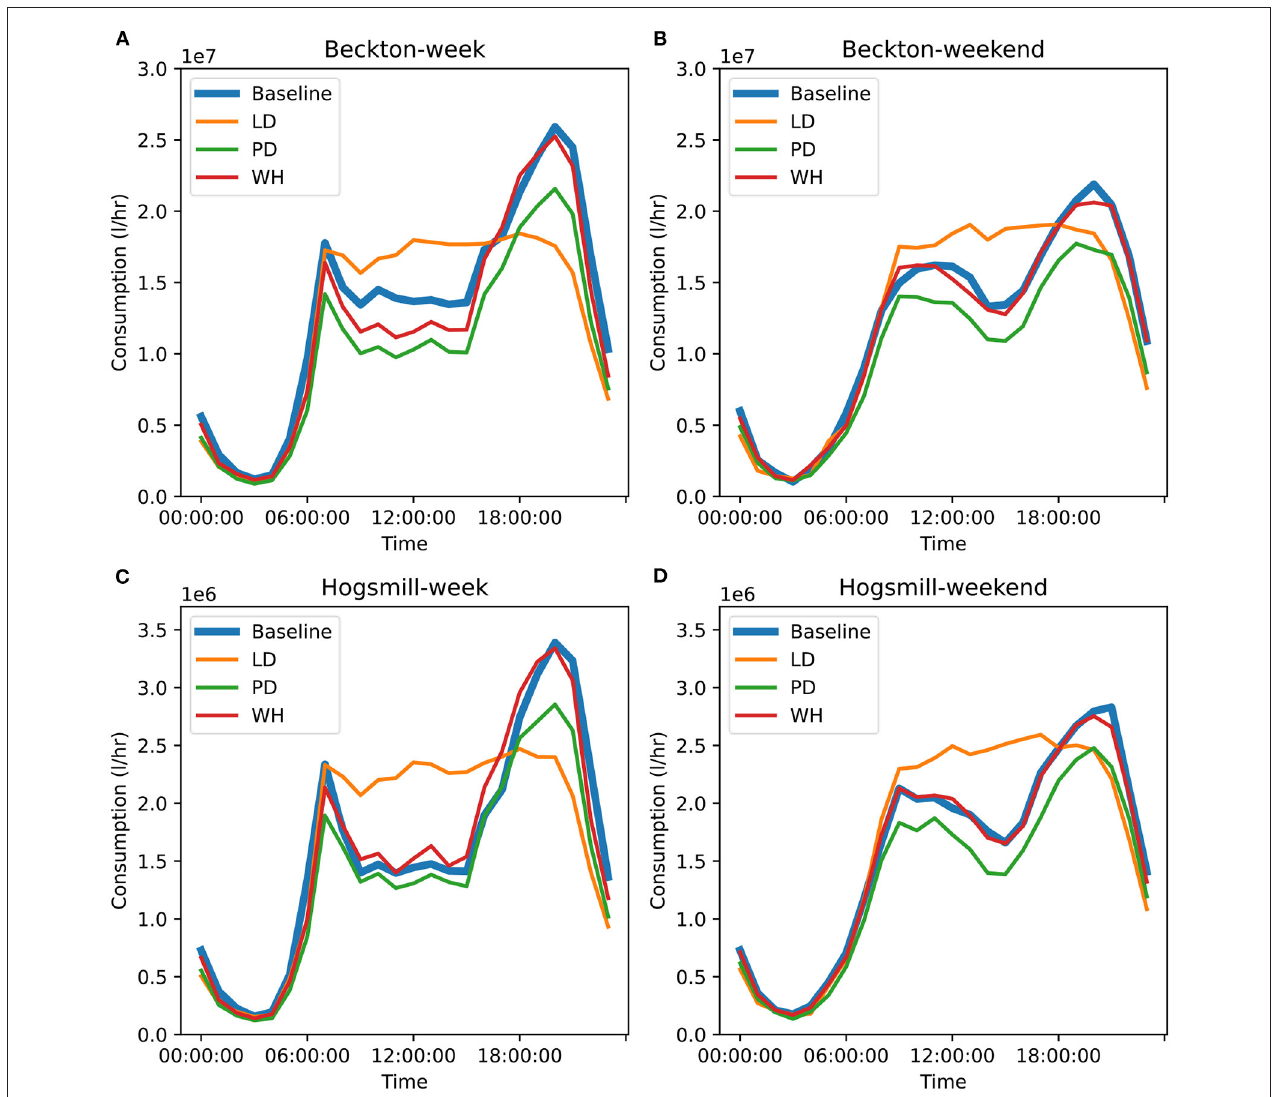
FIGURE 9 | Change in daily consumption profile in the Beckton wastewater zone (A,B) , and Hogsmill wastewater zone (C,D) , for both weekdays (A,C) and weekends (B,D) . Blue is baseline, orange is lockdown (LD), green is the population decrease (PD) scenario, red is work from home